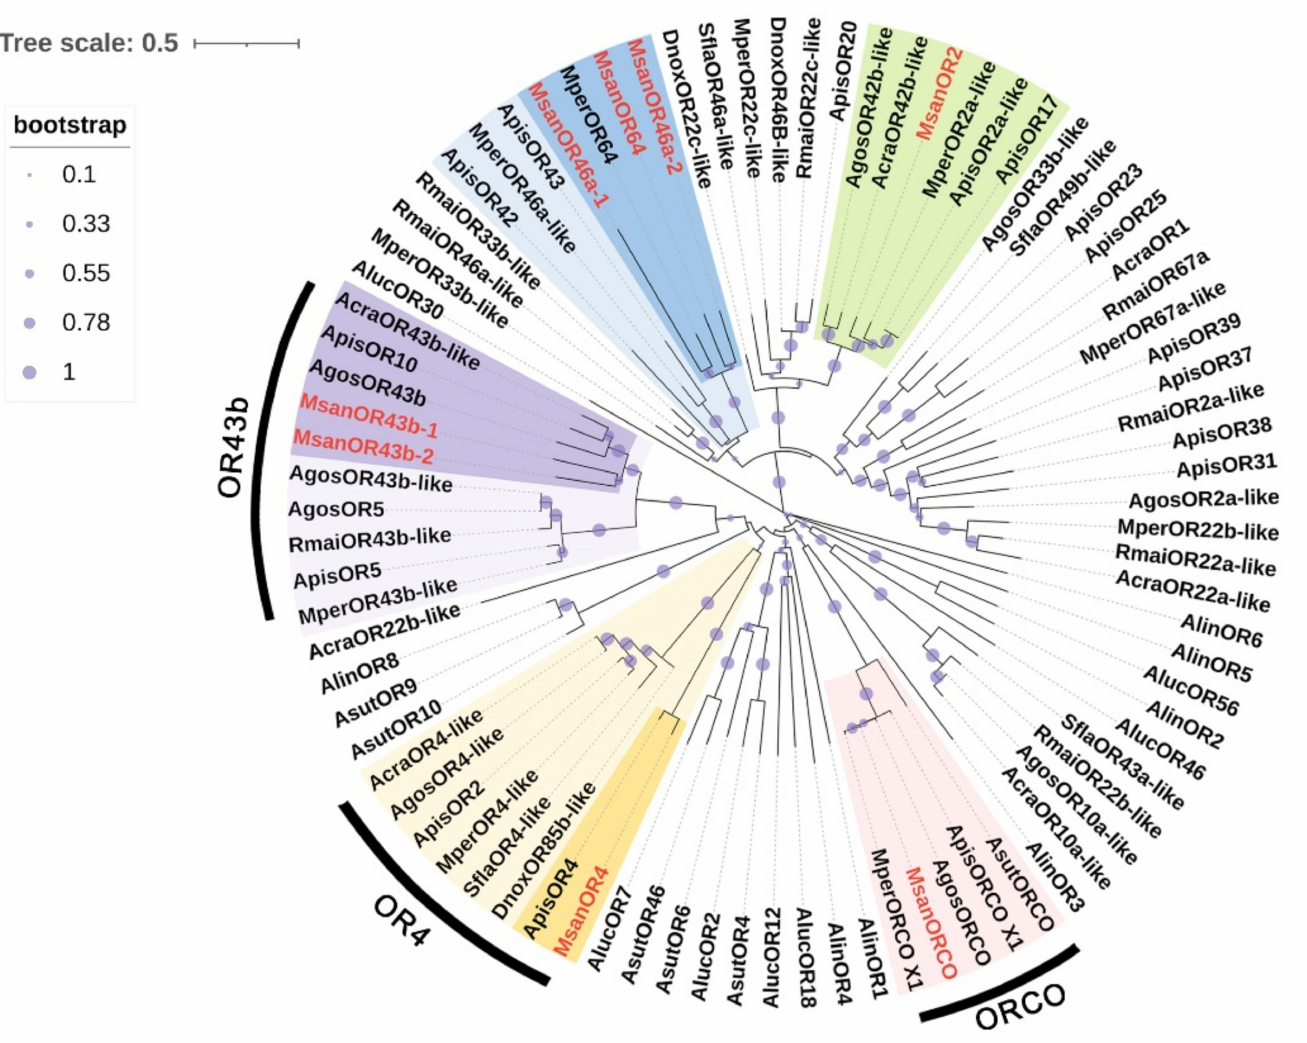
Figure 5. Phylogenetic tree of 85 odorant receptors (ORs) from 11 Hemiptera species. The phylo- genetic tree of Hemiptera ORs was built using 85 OR sequences from eight different aphid species (16 from Ac. pisum ; 10 from My. persicae ; 8 from R. maidis ; 7 from A. craccivora ; 4 from Sipha. flava ; 9 from A. gossypii ; 3 from Diuraphis noxia ; 8 from M. sanborni ) and three plant bugs (6 from Ad. suturalis ; 7 from Ad. lineolatus ; 7 from Ap. lucorum